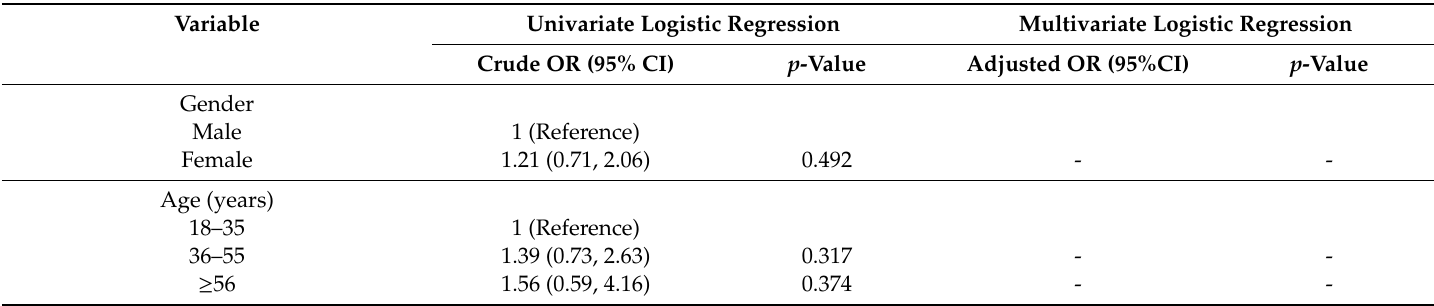
Table 4. Univariate and multivariate logistic regression for variables associated with generalized anxiety disorder